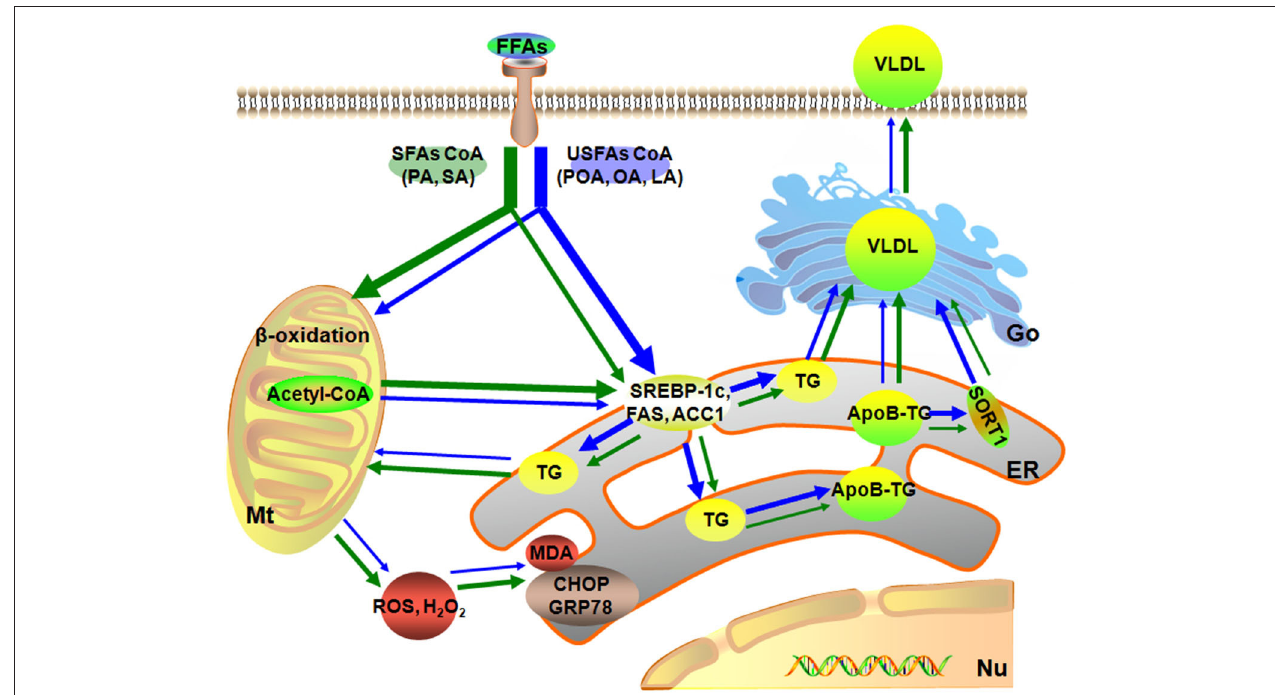
FIGURE 6 | Model of different fatty acids induced lipid accumulation and liver injury characteristics of primary calf hepatocytes. The green arrow represents the SFAs metabolic, blue arrow represents the USFAs metabolic. The thickness of the arrow represents the level of fatty acid metabolism. Mt, mitochondria; Nu, nucleus; ER, endoplasmic